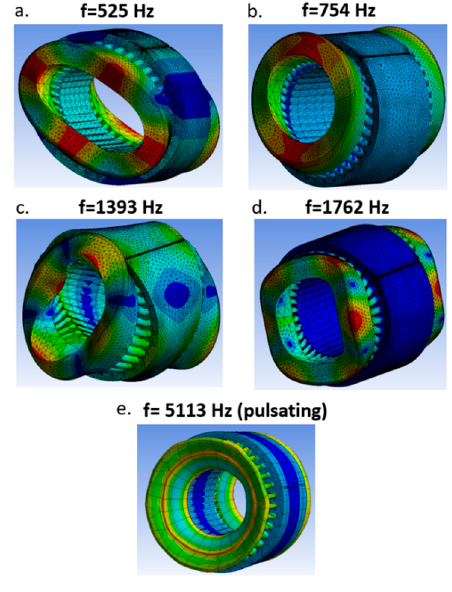
Figure 7. Numerically calculated modal shapes with the model of stator with slot and end-windings at the natural frequencies: ( a ) f = 525 Hz ( m = 2), ( b ) 754 Hz, ( c ) f = 1393 Hz, ( d ) f = 1762 Hz and ( e ) f = 5113 Hz (pulsating modal shape m = 0).